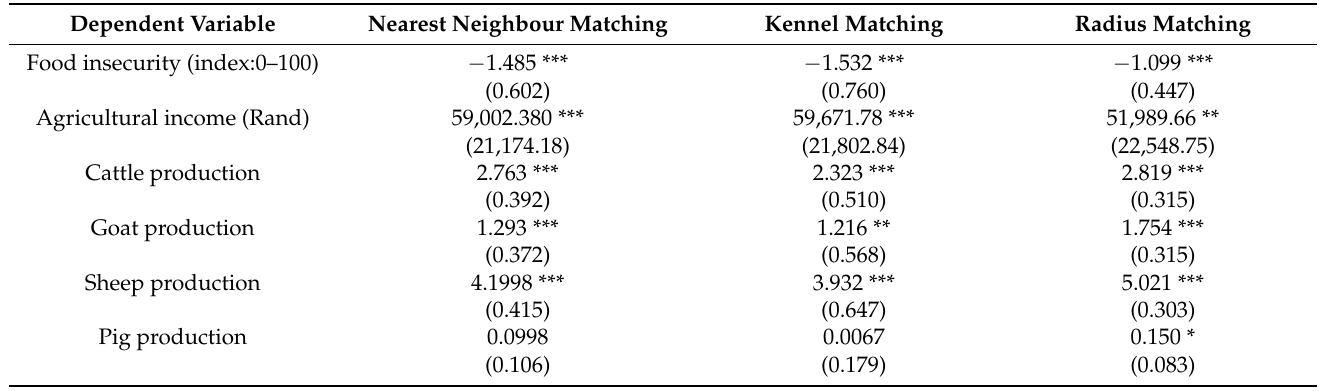
Table 3. Average Treatment Effects (ATE) of agricultural development